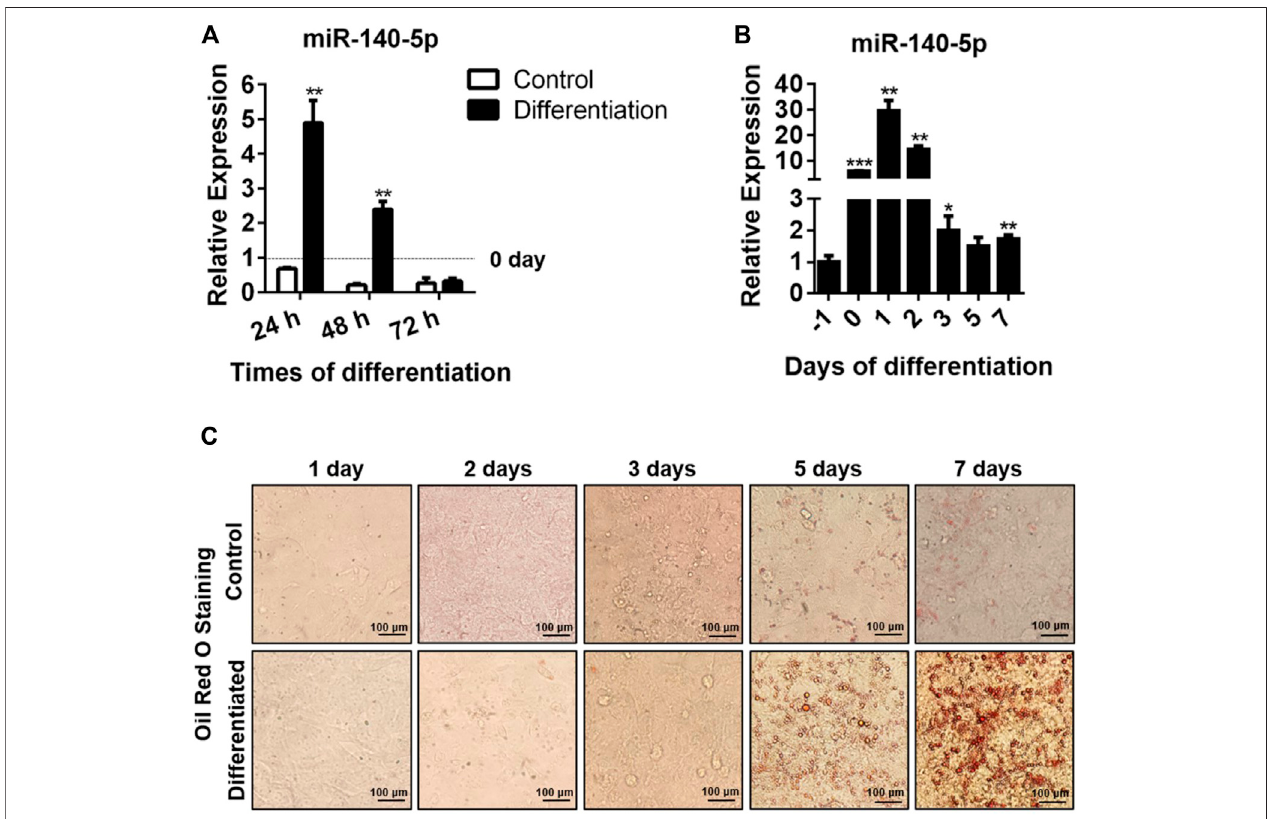
FIGURE 1 | miR-140-5p expression during adipocyte differentiation. (A) Expression of miR-140-5p at 24, 48, and 72 h during differentiation of preadipocytes treated with differentiation cocktail or DMI based on qRT-PCR. miR-140-5p expression in this study was normalized with U6 as the internal control. (B) miR-140-5p expression at diverse time points (1 day before differentiation, 0, 1, 2, 3, 5, and 7 days) during differentiation of preadipocytes. 3T3-L1 cells were inoculated with differentiation cocktail or DMI based on qRT-PCR. (C) Oil red O staining of preadipocytes at diverse time points (1, 2, 3, 5, and 7 days) during differentiation (100- fold magni fi cation). Data are given as mean ± SD (n = 3, with three replicates in one independent experiment). Remarkable difference is given at the levels of * p < 0.05, ** p < 0.01, and *** p < 0.001 via two-tailed Student ’ s t